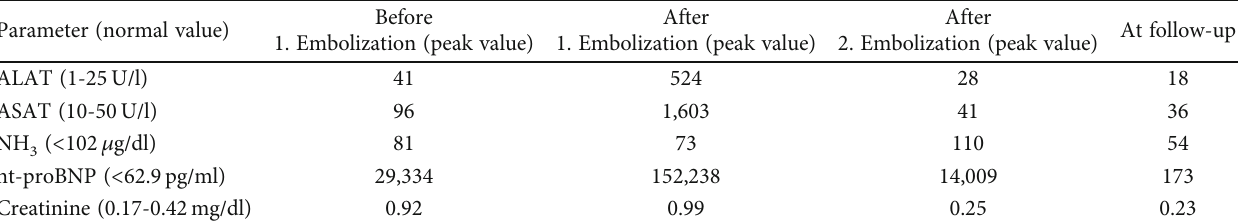
Table 3: Laboratory summary of patient 4 (hepatic